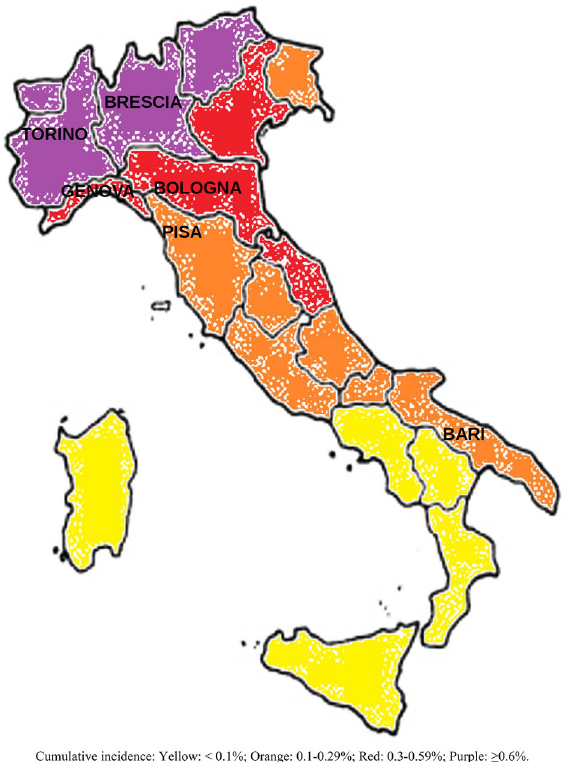
Figure 1. Cumulative incidence of SARS-CoV-2 infection (both sexes combined) as of 6 May 2020 in Italian regions, and centers included in the